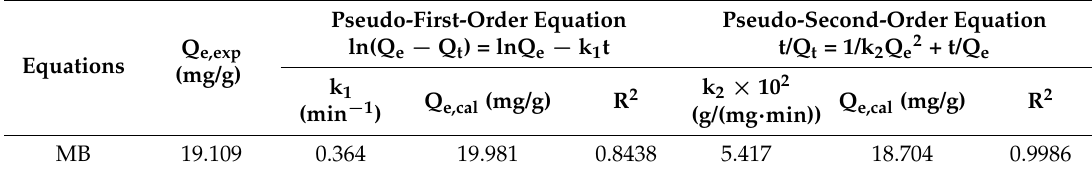
Table 4. Parameters of the pseudo-first-order model and pseudo-second-order model for the adsorption of MB onto CCT-BFO.